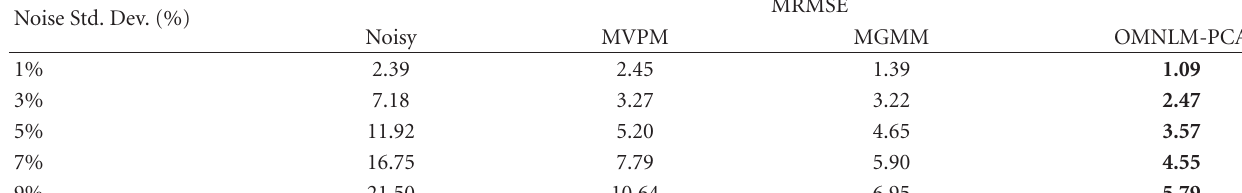
Table 3: Comparison of the proposed filter with MGMM and MPVM methods for di ff erent noise levels. The original MRMSE of the 4 unprocessed images was supplied for reference purposes. As can be noticed the proposed method was the best for all noise levels. Noise Std. Dev. (%)